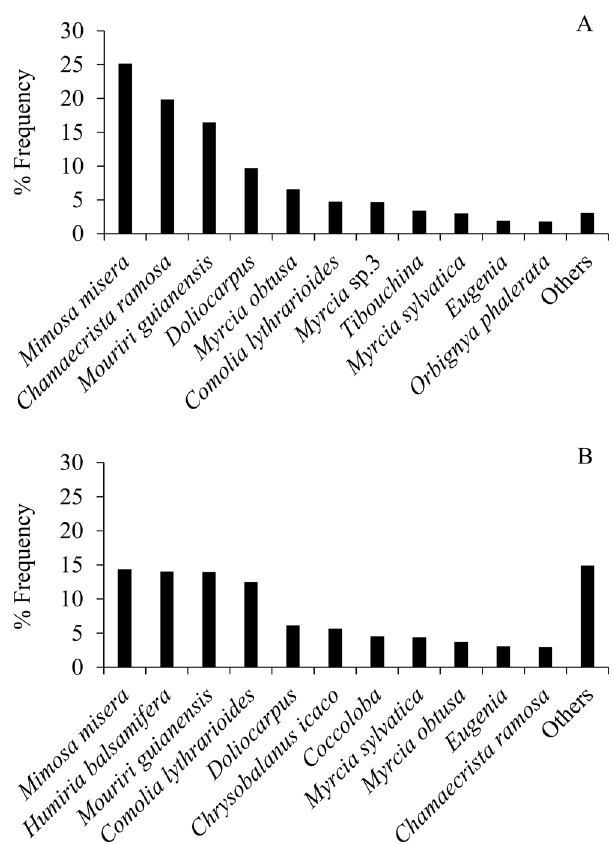
Fig 1. Percentages of pollen types identified in the samples from (A) pollen pots and (B) honey pots of Melipona subnitida in a restinga area, Maranhão state, Brazil.